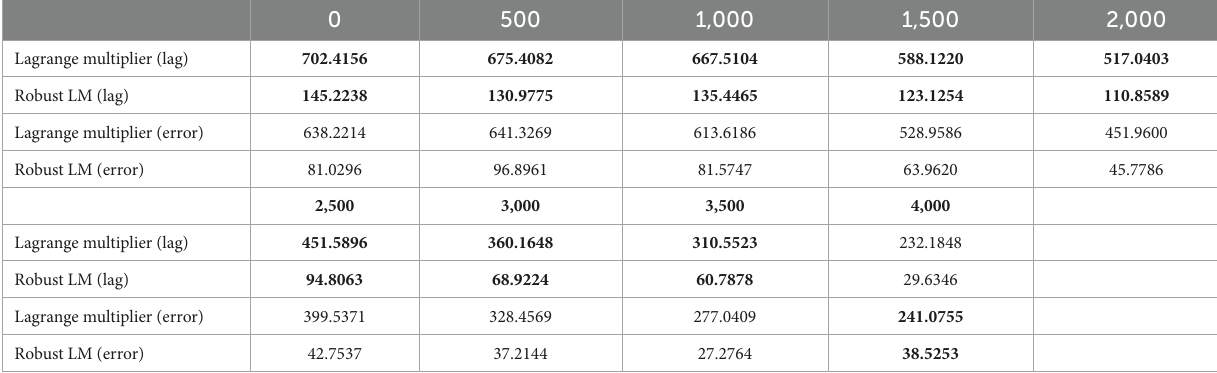
TABLE 2 Lagrange multiplier method for spatial dependence diagnosis (model 1–model